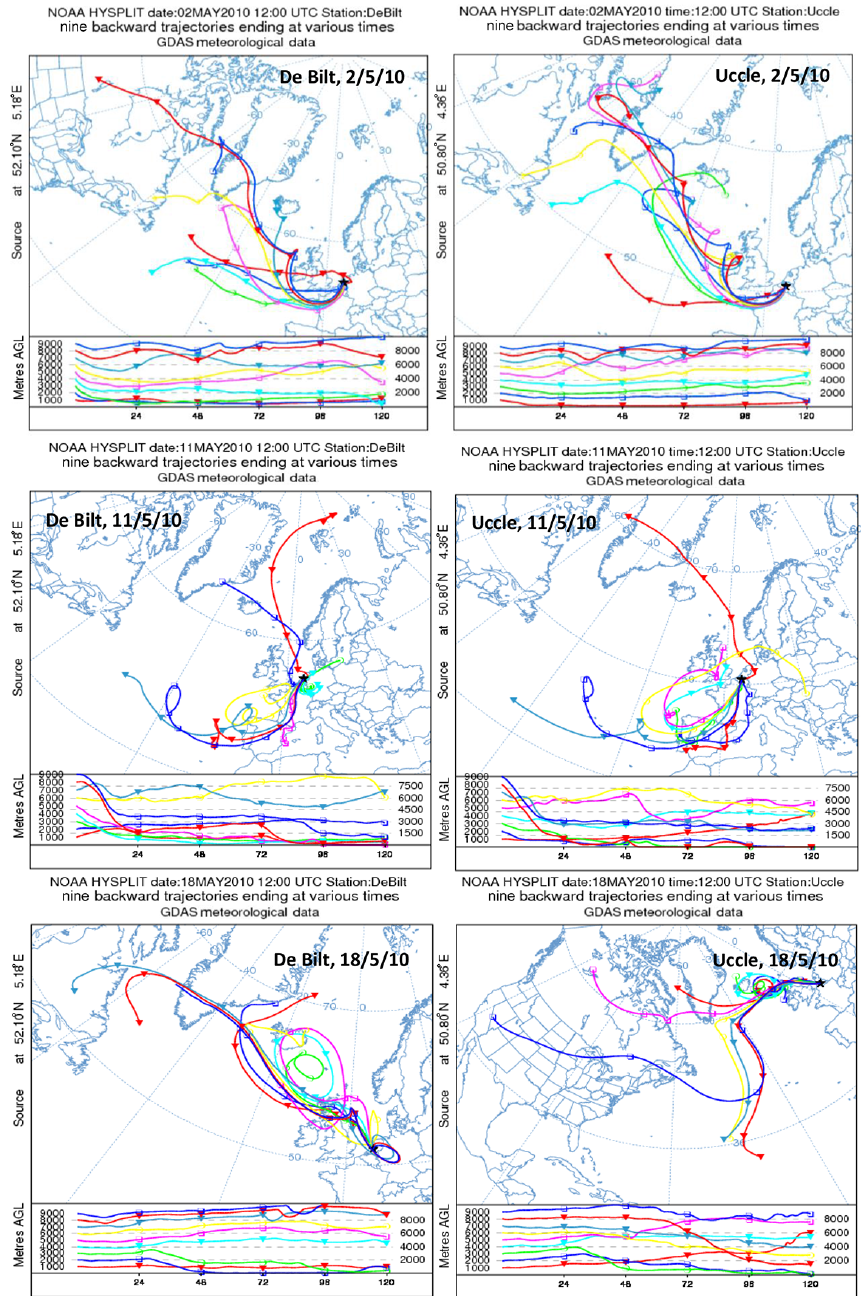
Figure 13. HYSPLIT 120h back trajectories of air masses arriving at De Bilt (left column) and Uccle (right column) on 2 May 2010 (first row), 11 May 2010 (second row) and 18 May 2010 (third